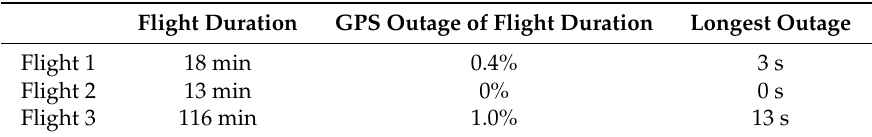
Table 6. GPS outages during flight